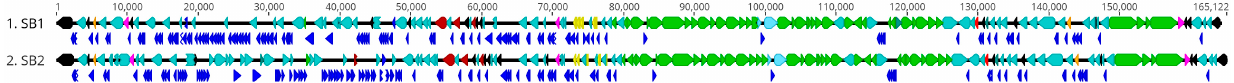
Figure 10. Genome maps of DLP1 and DLP2. Functional assignment of the predicted proteins encoded by each open reading frame is as follows: hypothetical (navy), morphogenesis (green), tran- scription and translation (teal), regulatory (black), lysis (pink), terminase (light blue), recombination (dark red), resistance (orange), tRNA (yellow), and virulence (red).